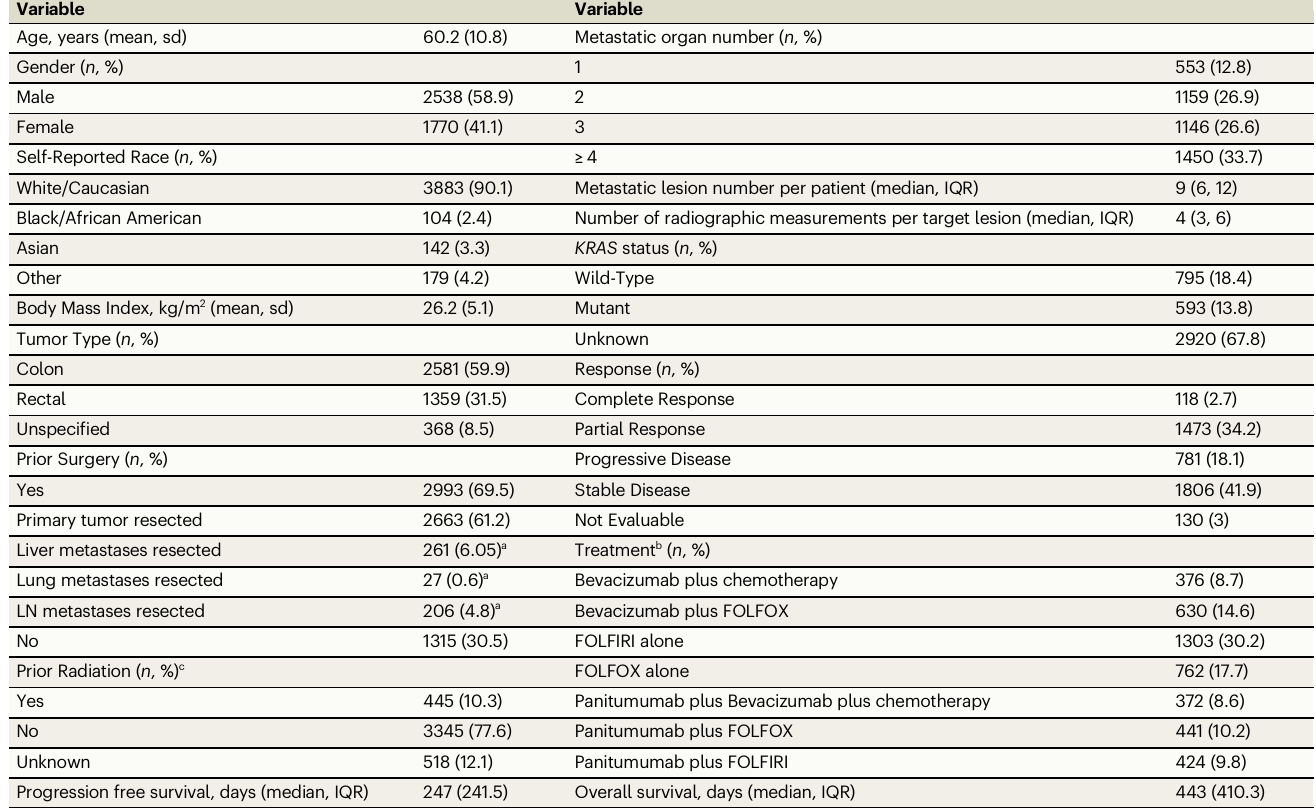
Table 1 | Demographic information of colorectal cancer patients